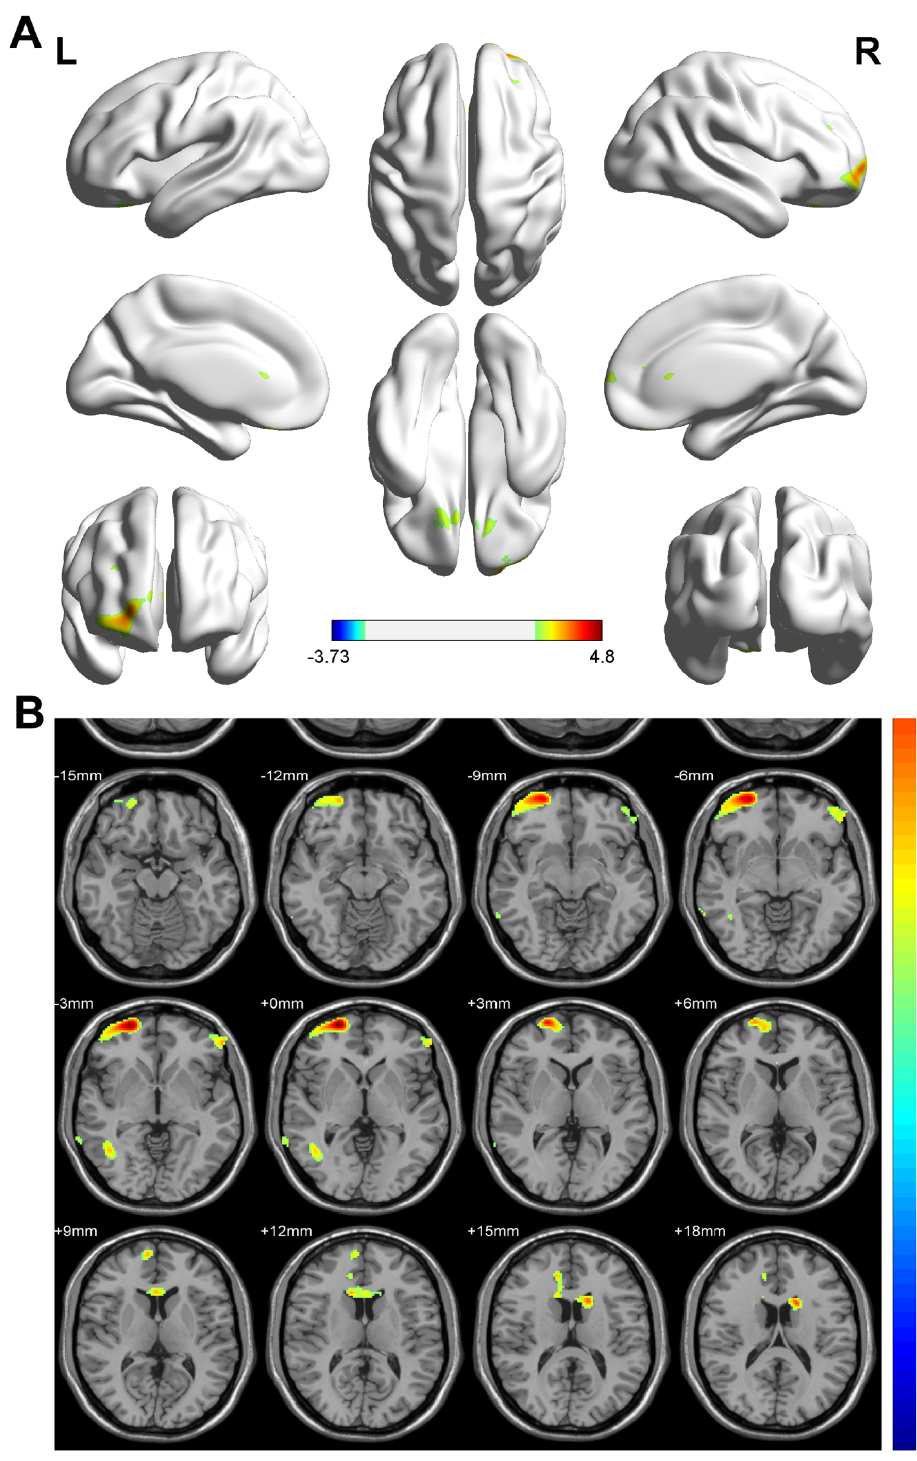
Fig 3. Comparison of regional gray matter volume measures by VBM. The results are shown in a 3D view in A and a 2D view in B. The threshold was set at p < 0.01 after the Bonferroni correction given a cluster size � 40 voxels. Multiple regions had higher gray matter volumes in breastmilk-fed infants than in formula-fed infants. The regions are highlighted in yellow (breastmilk-fed > formula-fed). All images are displayed according to the radiologic convention (left/right